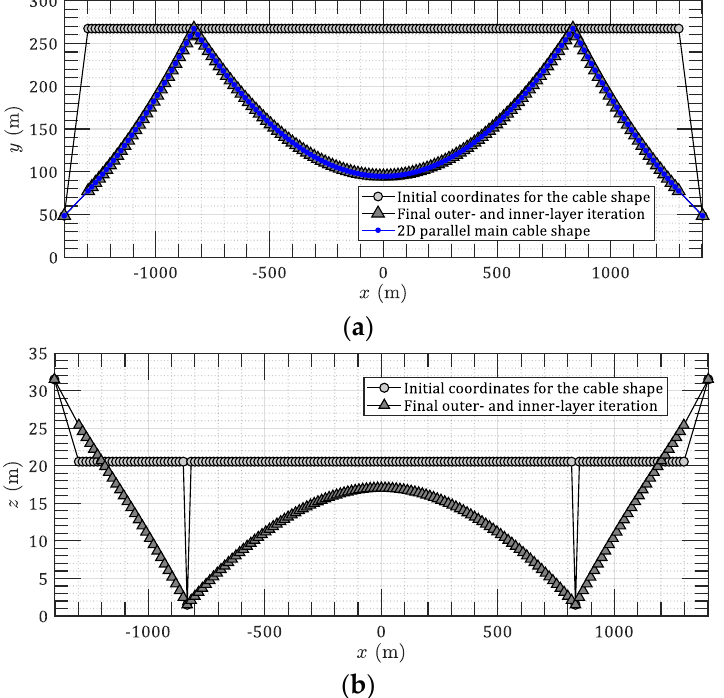
Figure 12. The main cable shape from the initial coordinates to the target configuration for 3D spa- tial main cables: ( a ) y -direction; ( b ) z -direction. main cables: ( a ) y -direction; ( b ) z